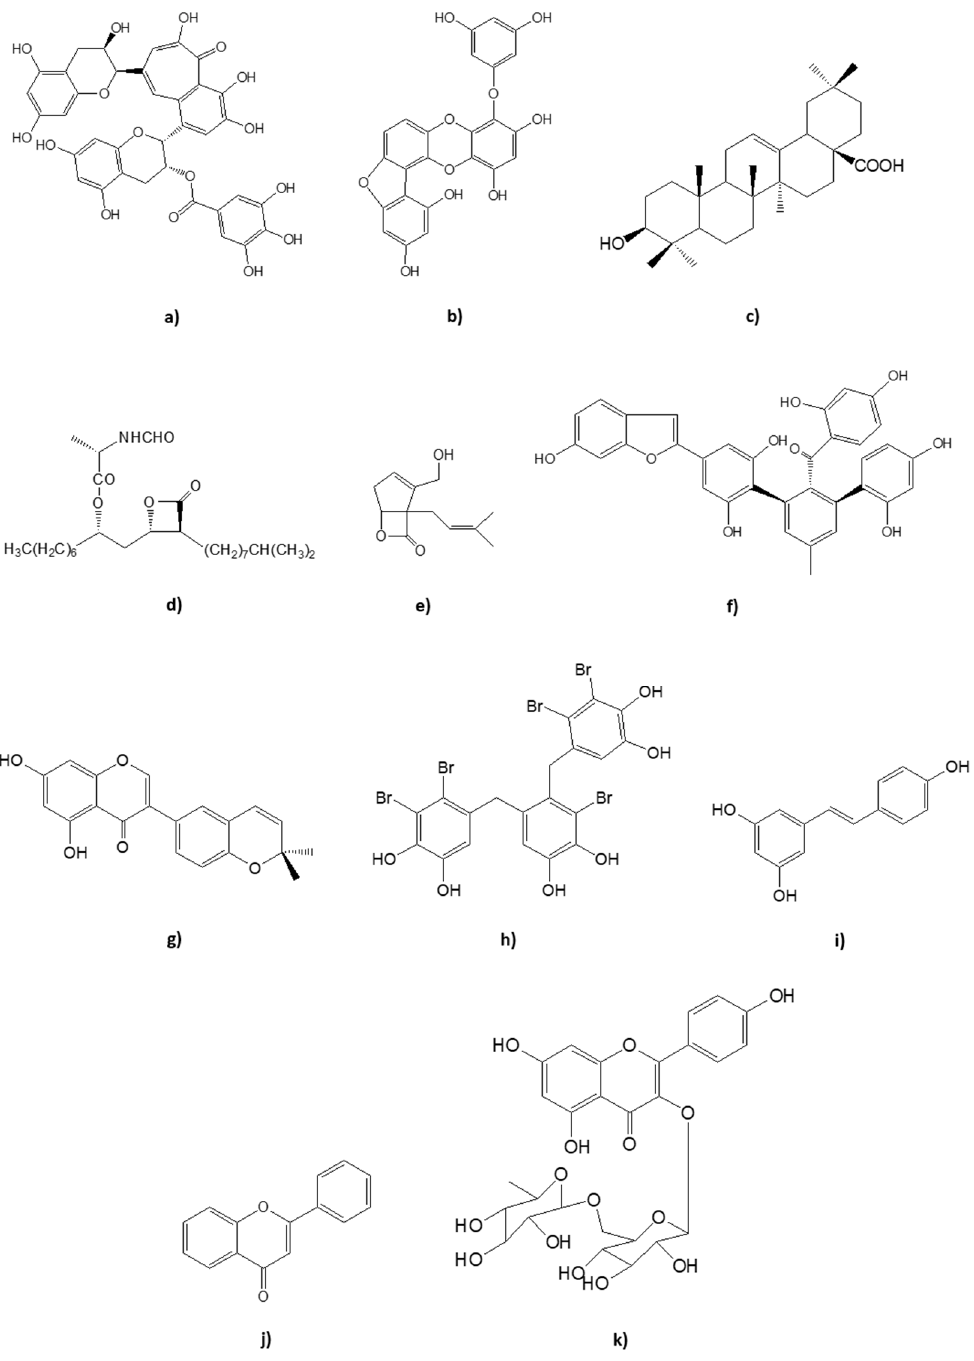
Figure 1. Examples of chemical structures of some of the natural compounds with inhibitory activity against target enzymes in the prevention and control of T2DM. ( a ) theaflavin-3-gallate; ( b ) fucofuroeckol A; ( c ) triterpene oleanolic acid; ( d ) panclicins A; ( e ) percyquinnin; ( f ) mulberrofurans J; ( g ) isoderrone; ( h ) 3-bromo-4,5-Bis-(2,3-dibromo-4,5-dihydroxybenzyl) pyrocatechol; ( i ) resveratrol; ( j ) flavone; ( k ) kaempferol diglycoside.